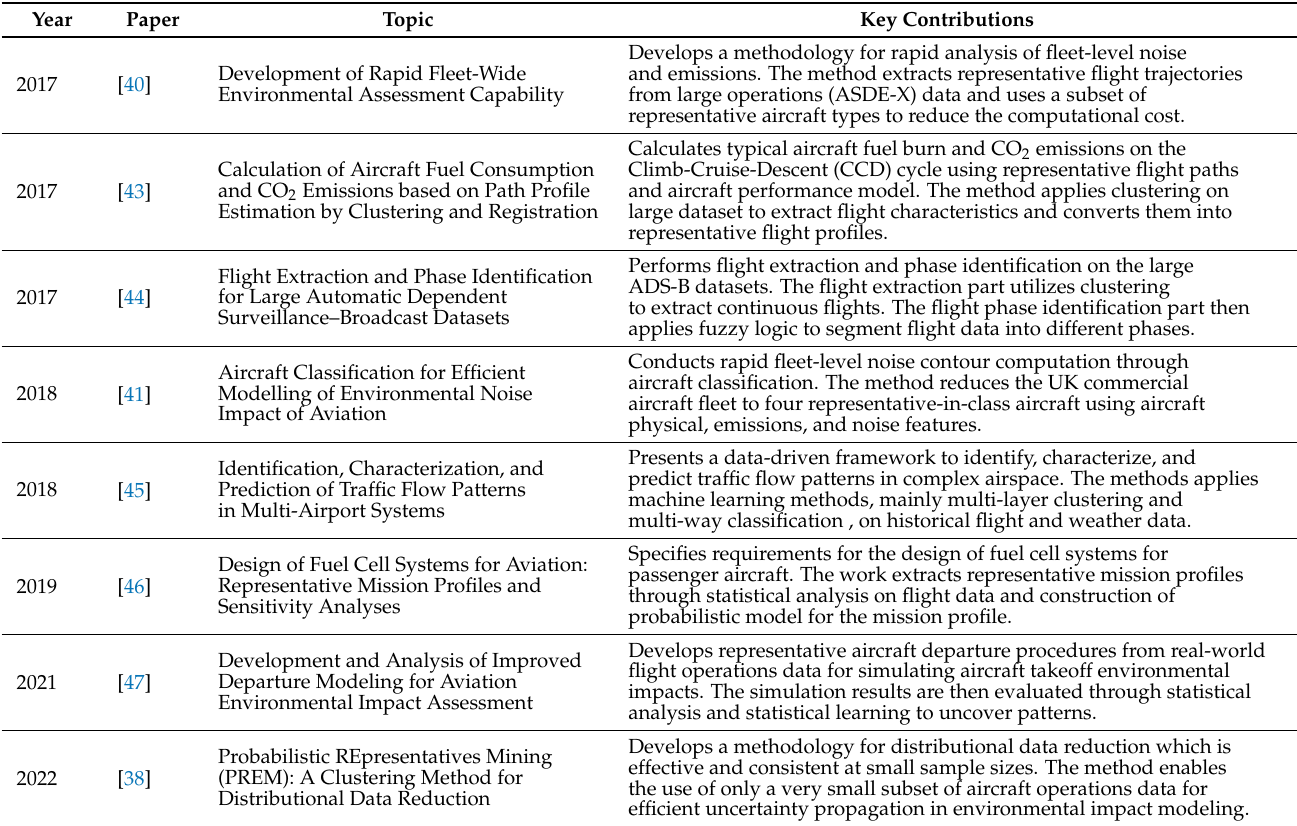
Table 2. Summary of representative papers in data